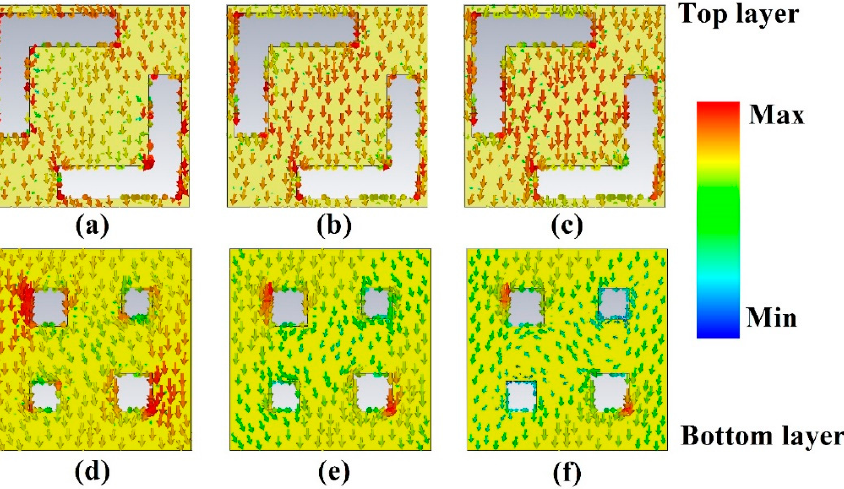
Figure 6. The distribution of surface currents on top and bottom films at different frequencies. ( a - c ) The distribution of surface currents at 6GHz, 12 GHz and 18 GHz on top layer. ( d - f ) The distribution of surface currents at 6GHz, 12 GHz and 18 GHz on bottom layer.